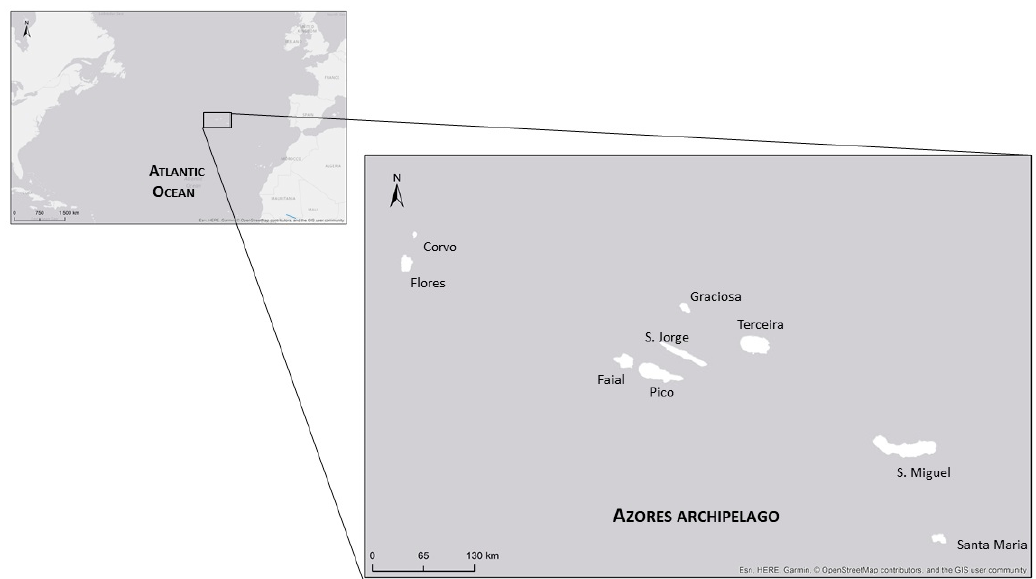
Figure 1. Location and map of the Azores archipelago.